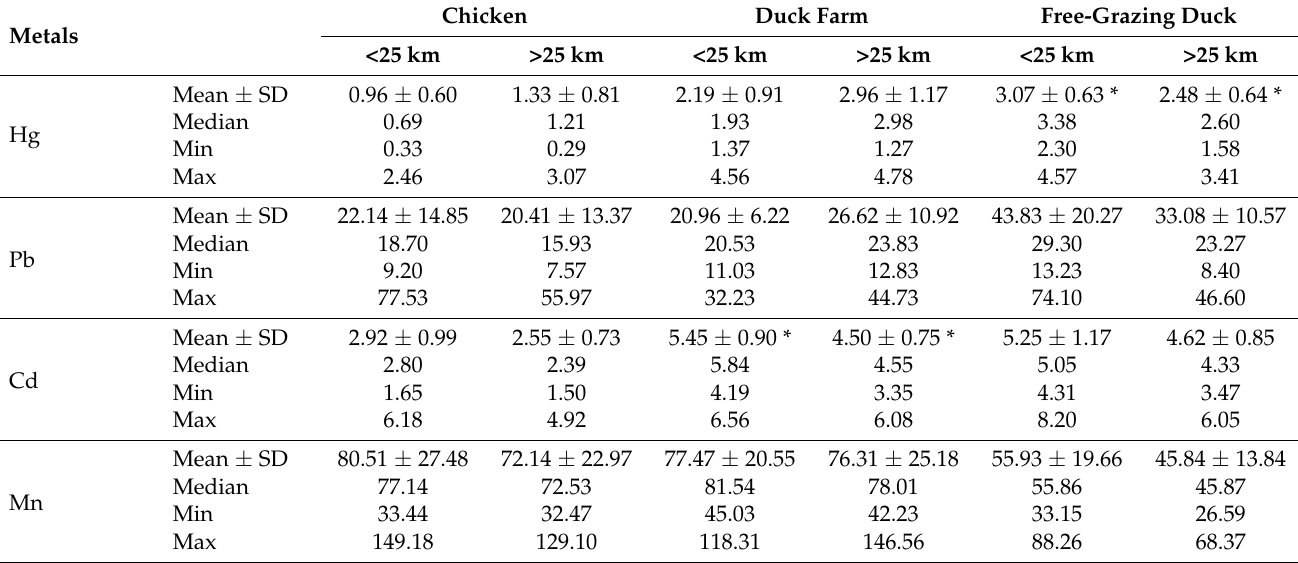
Table 2. Mean ± SD, the median, minimum, and maximum values of Hg, Pb, Cd, and Mn concentra- tions in poultry blood ( µ L L − 1 ).